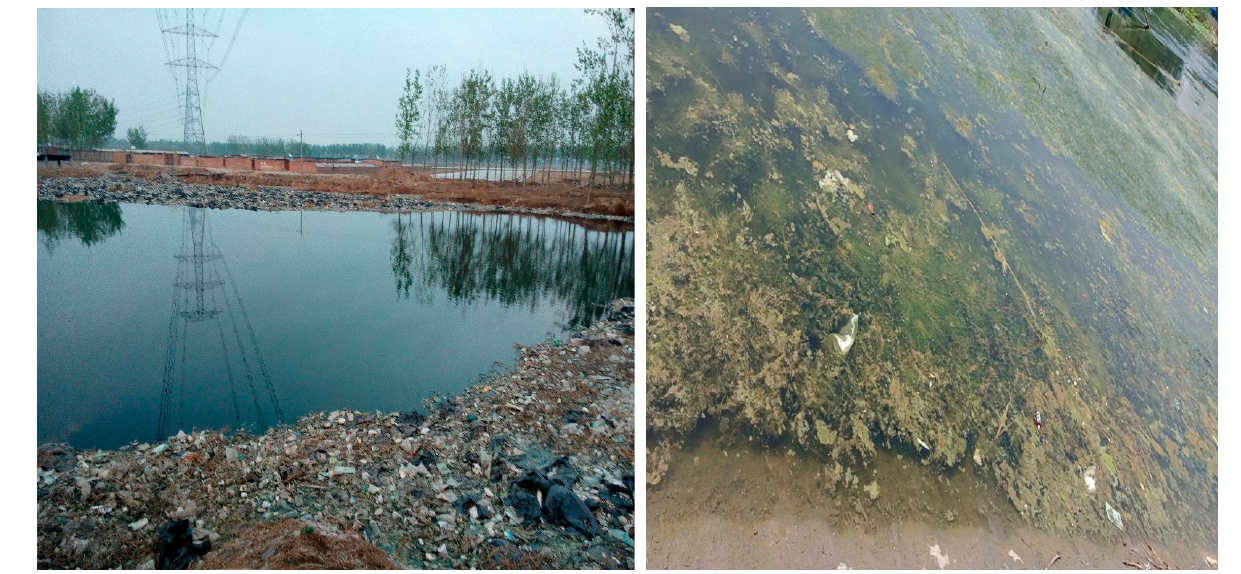
Figure 3. Water pollution in Hebei Province (taken in April 2018) and Fujian Province (taken in September